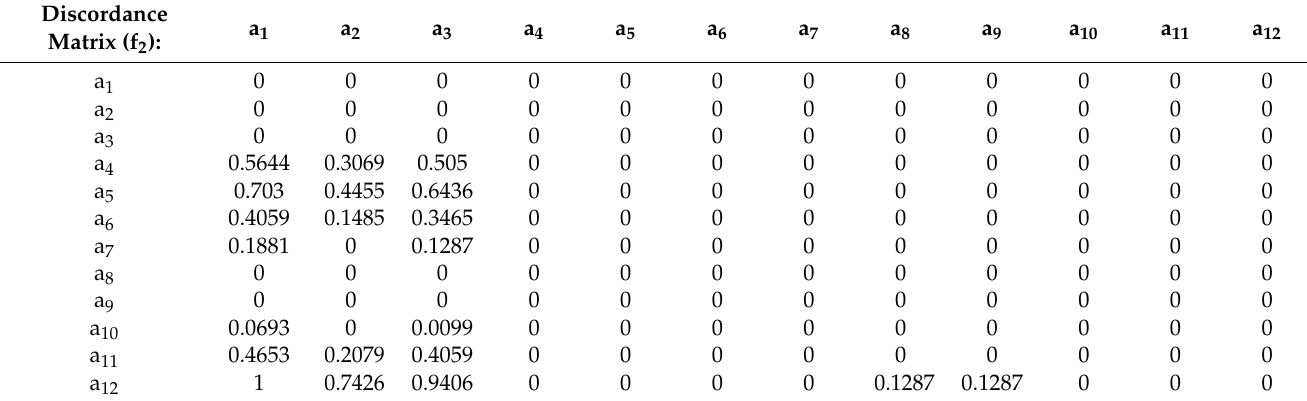
Table A2. Values of the non-compliance indicators according to the 2nd criterion.